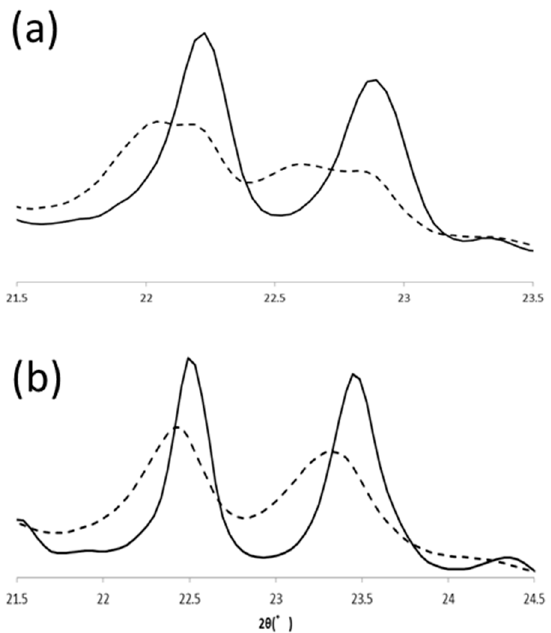
(cid:48) (cid:48) Figure 8. Comparison of initial ( β 2 β , β 4 α ) and final ( β 1 β , β 3 α ) β forms of PPP. SR-XRD patterns in Figure 8. Comparison of initial ( β 2 β′ , β 4 α ) and final ( β 1 β′ , β 3 α ) β forms of PPP. SR-XRD patterns in ( a ) β ’ ( a ) β ’ and ( b ) α routes. The dotted and solid lines are for initial and final β forms, and  b  α  routes. The dotted and solid lines are for initial and final β forms, respectively.